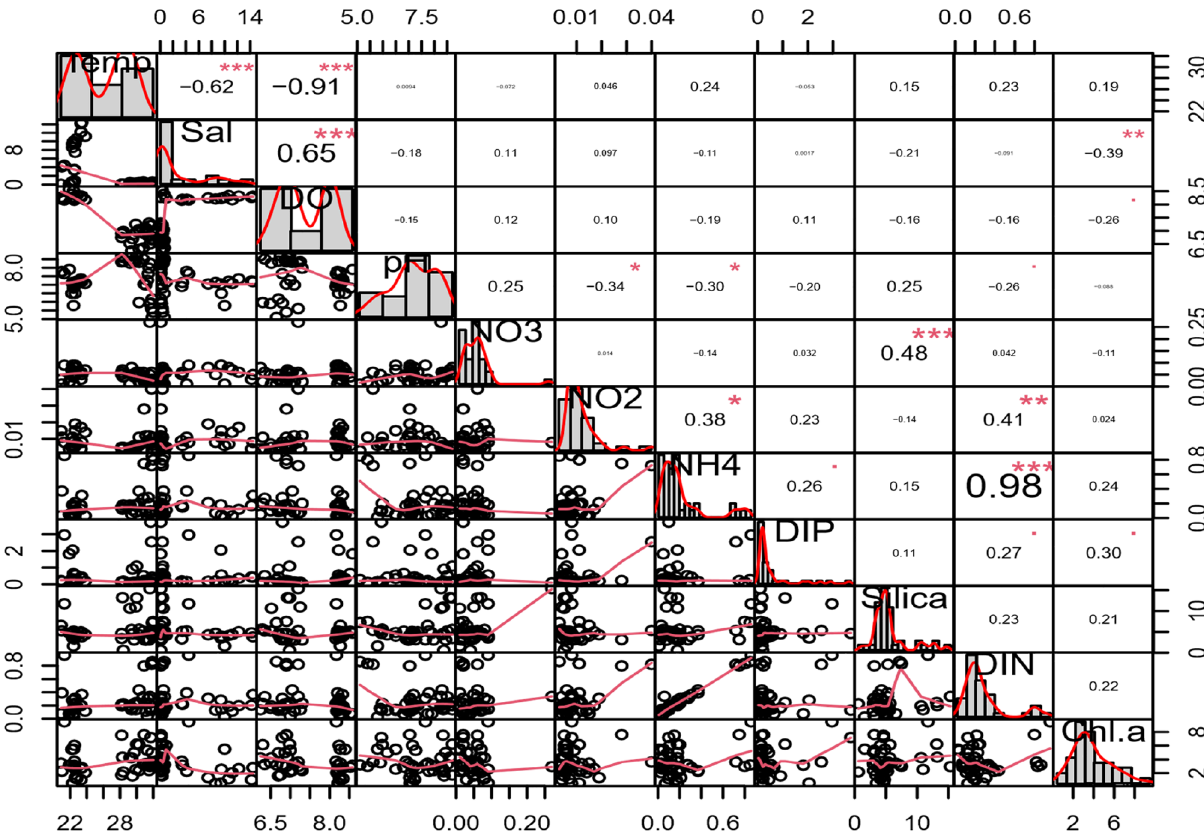
Figure 7. The correlation plot among the ten-water quality parameter. The values given around each axis are a range of individual parameter. The correlation coefficient (r) is indicated by a numeric value and the significance levels (p) is indicated by asterisk (* < 0.05, ** < 0.01, *** <